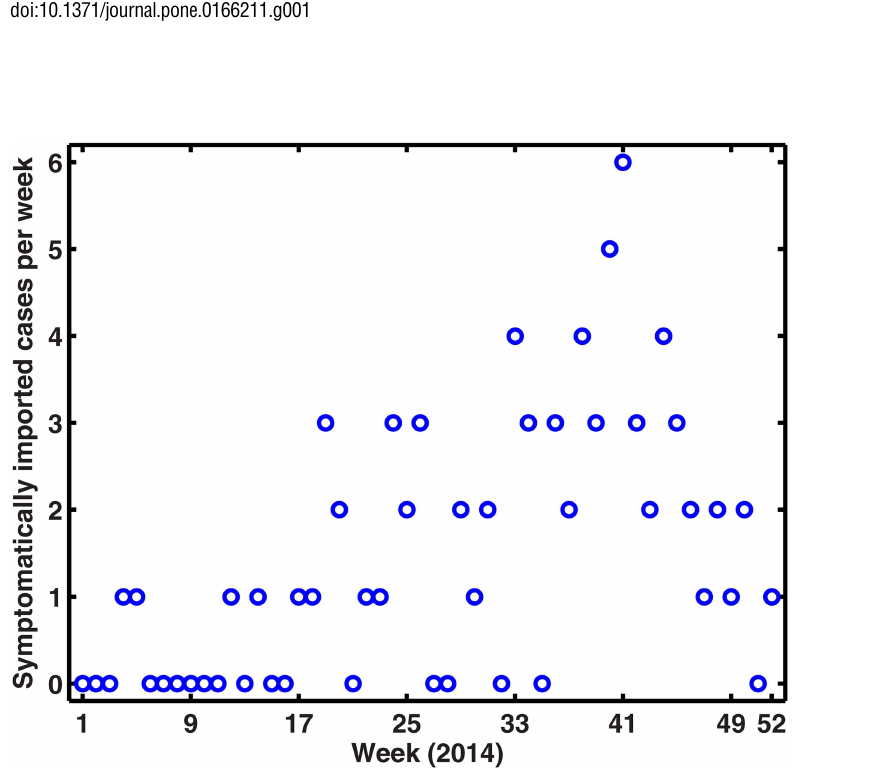
Fig 2. The weekly imported dengue cases in Guangdong,